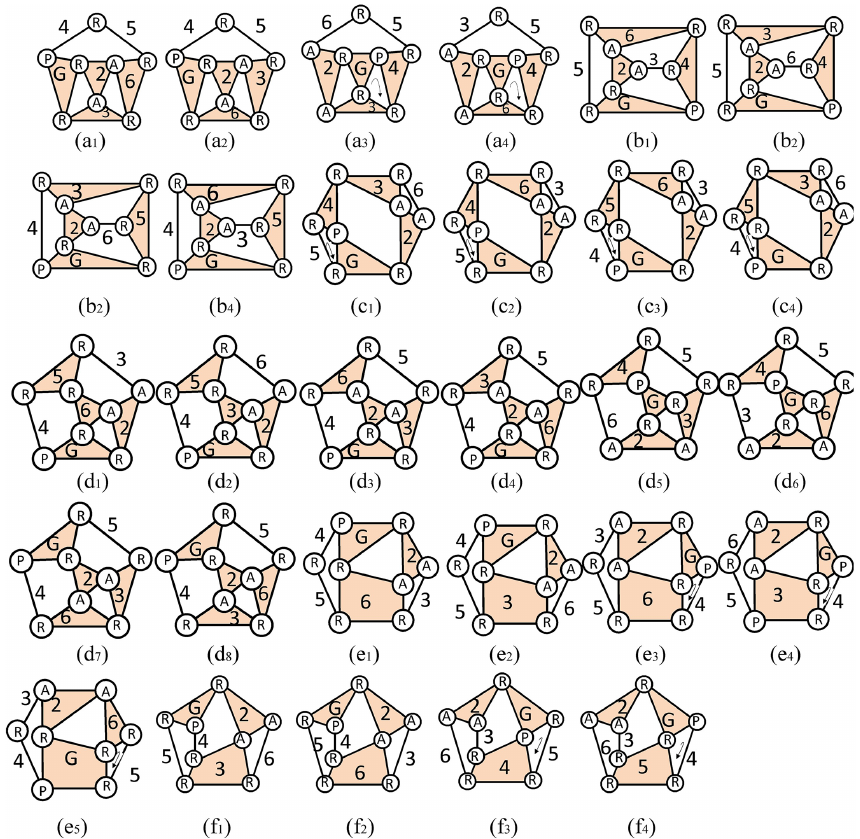
Figure 16. The specialized chains – model